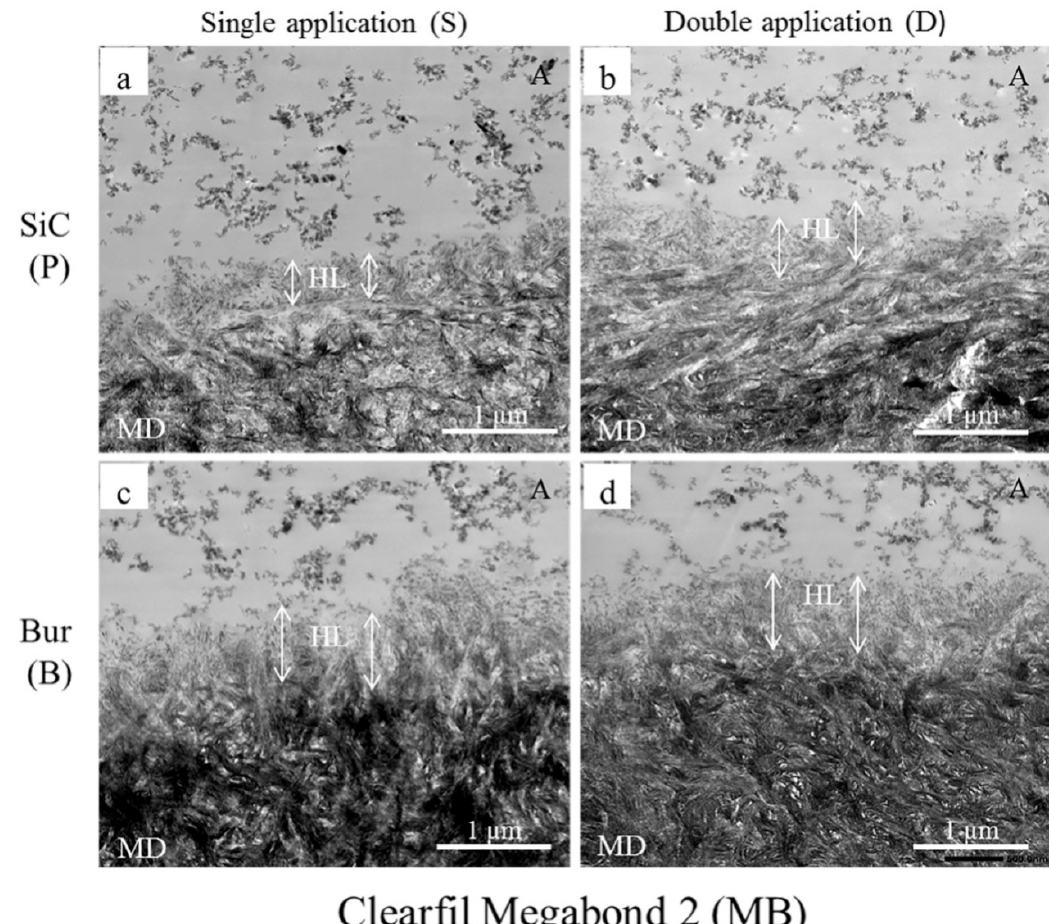
Figure 3. Representative TEM images (20,000 × ) of resin-dentin interfaces created by Clearfil Megabond 2 (MB) with 180-grit SiC paper-prepared ( a , b ) and fine-grit diamond bur-cut dentin ( c , d ) in single ( a , c ) and double application ( b , d ) modes. A represents an adhesive containing scattered nano-sized filler particles, albeit less scattered compared to what was observed in G-Premio Bond (GP). The double-ended white arrows represent the extension of the hybrid layers (HL) from beneath the filler-containing adhesive layer up to the electron-dense mineralized dentin (MD). Double application ( b , d ) did not yield marked changes from their single application counterparts ( a , c ), depicted in the images by similar lengths of the white arrows on either side of the HL.